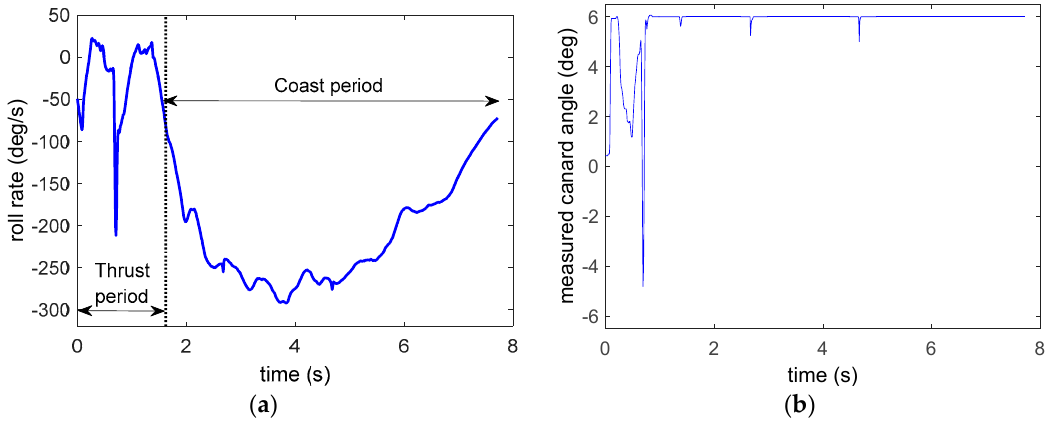
Figure 19. Data for analysis ( a ) Roll rate response; ( b ) Measured canard angle from encoders.